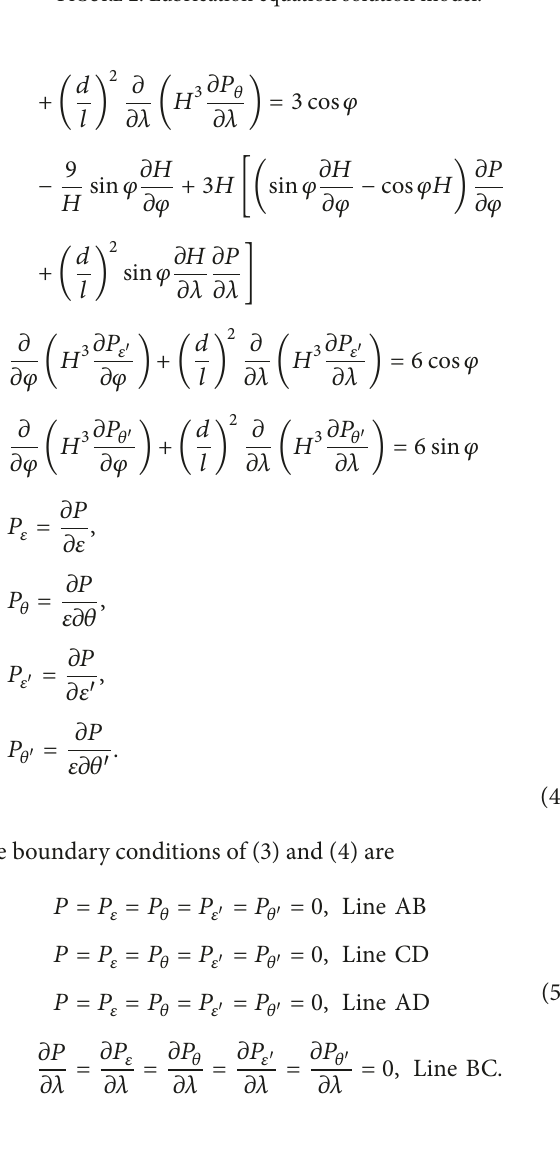
Figure 2: Lubrication equation solution